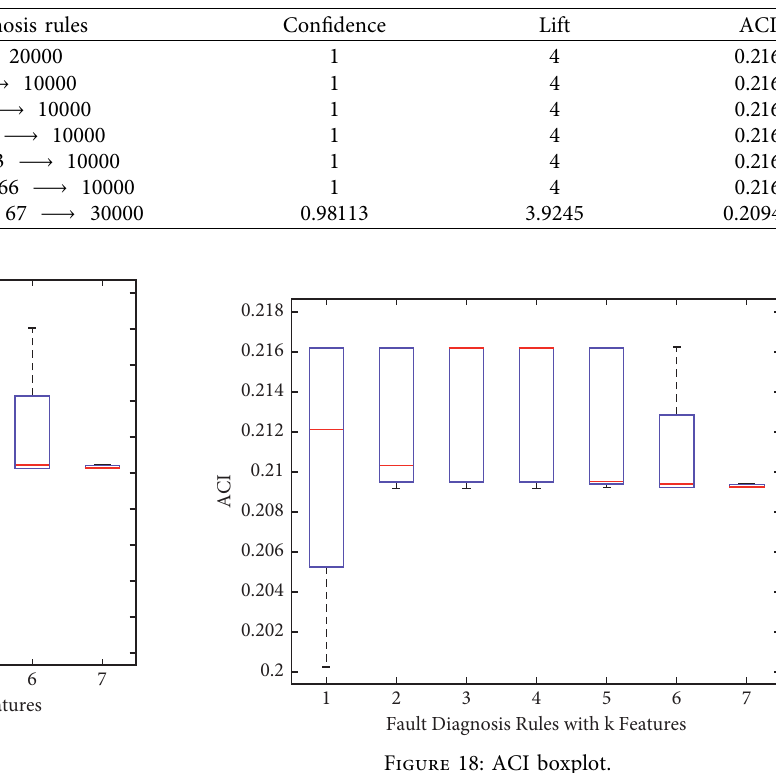
Figure 16: Confidence boxplot.